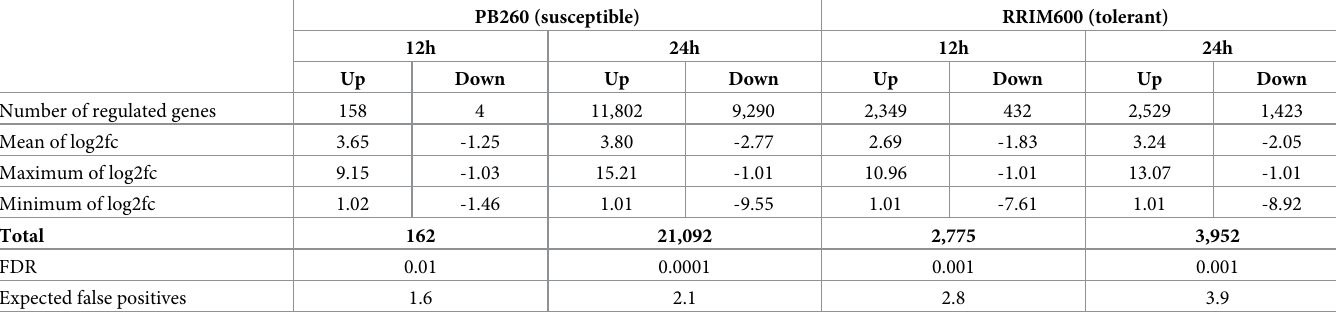
Table 1. Numbers of DEGs 12 and 24 hours after cassiicolin application on PB260 and RRIM600 rubber